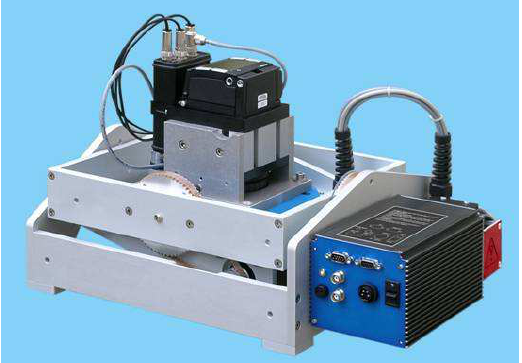
Figure 5: mid-format camera on the gyro stabilised platform